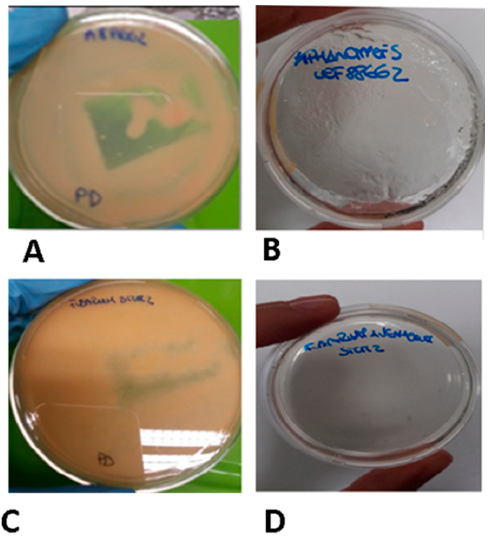
Figure 5. Sporicidal effect of the chloroform–methanol Zr-b extract, in an in vitro spore germination inhibition assay. No viable colonies of Aphanomyces astaci ( B ) and Fusarium avenaceum ( D ) were observed on media supplemented with the chloroform–methanol Zr-b extract (right panel). Left panel: growth control on PD agar of Aphanomyces astaci ( A ) and Fusarium avenaceum ( C ) without the Zr-b extract.